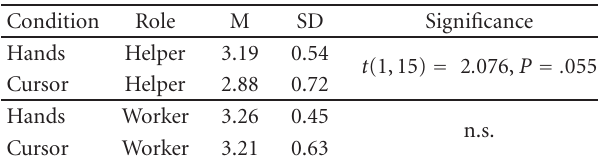
Table 1: Helper and worker’s satisfaction. (M: mean; SD: standard deviation; n.s.: not significant).